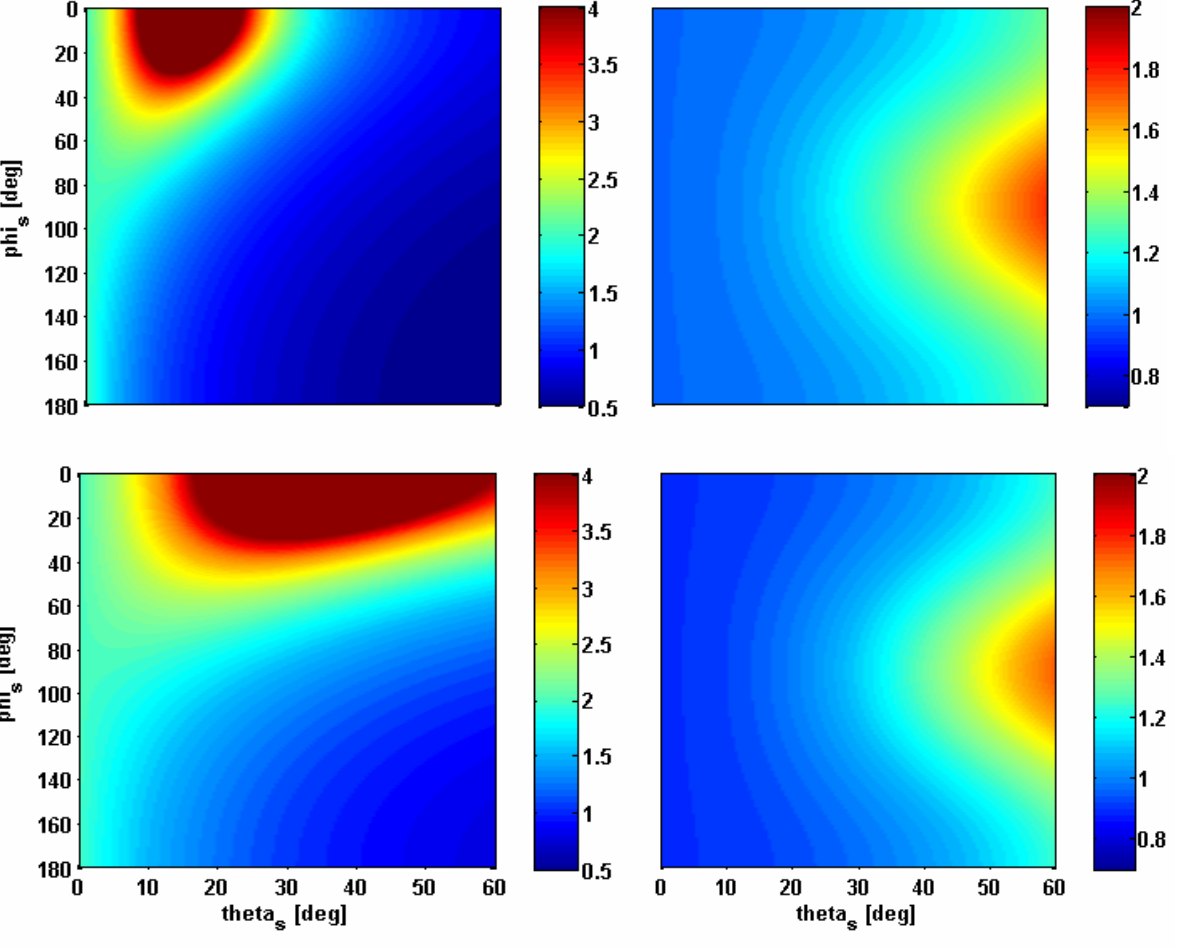
/  grback (left panels) and  Figure 2. Maps of  gr = 35° (lower panels) in the ( θ panels) and θ i upper limited to 4 times the backscattering value for the sake of figure